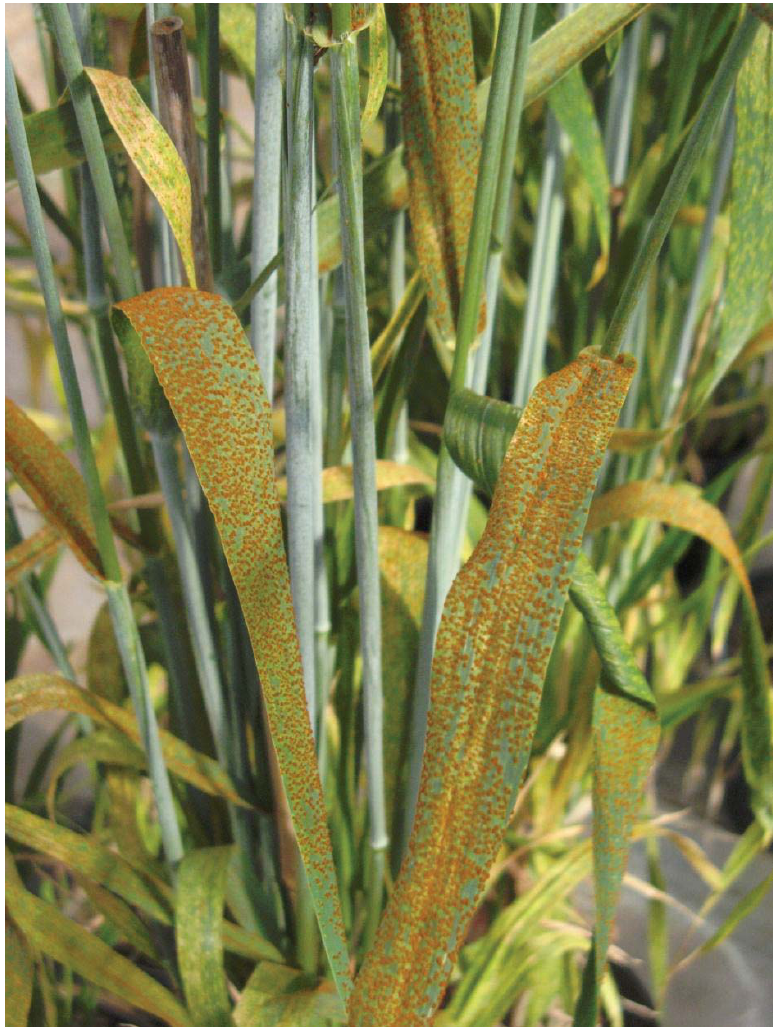
Figure 1. Uredinia of Puccinia triticina (leaf rust) on flag leaves of wheat. Photo by Mark Hughes,